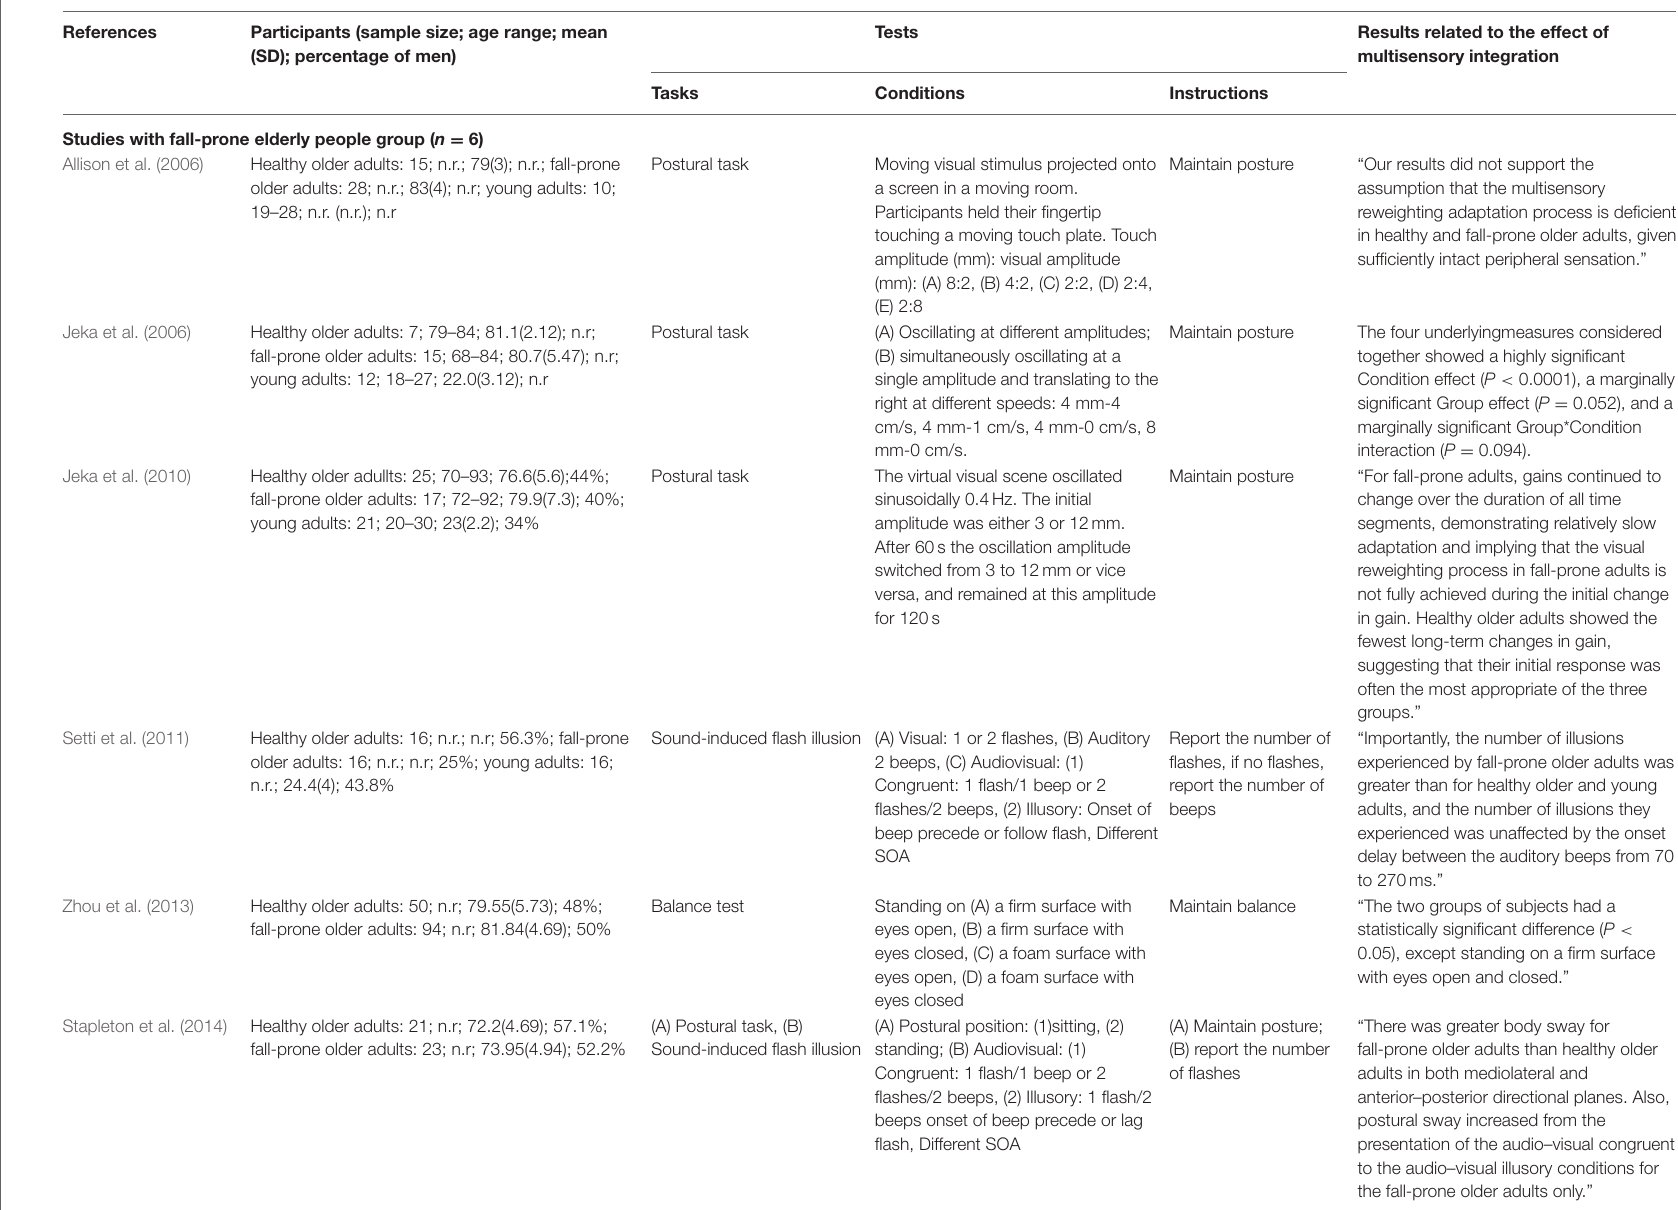
TABLE 4 | Characteristics of studies in the systematic review ( n = 17).